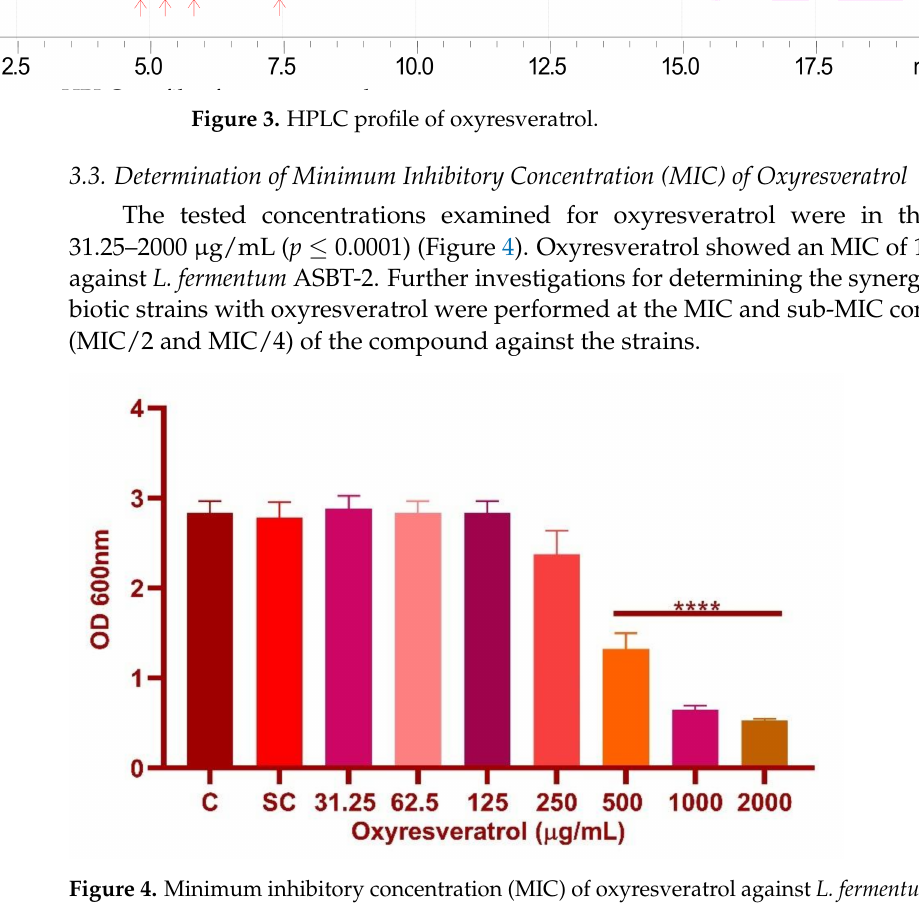
Figure 4. Minimum inhibitory concentration (MIC) of oxyresveratrol against L. fermentum . The tested concentrations examined for oxyresveratrol were in the range of 31.25–2000 µ g/mL. **** Significantly different ( p ≤